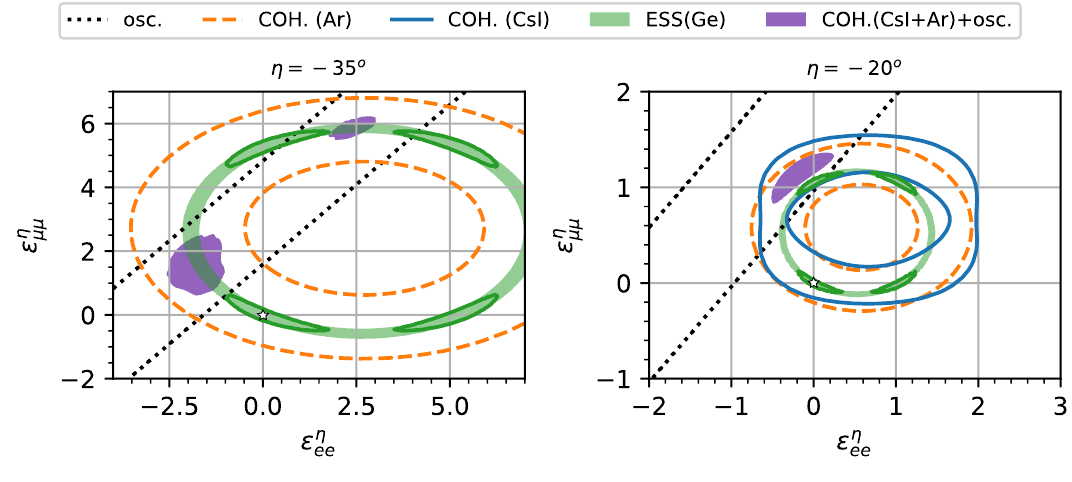
Figure 6 . Same as figure 2 but showing allowed regions at 3 σ from a Ge target at a stopped pion source assuming a precision of σ/Q 2 = 0 . 028 , a factor 5 better than the ESS assumption from [23]. SM For the green-shaded region (green-solid contours) we assume σ µ /σ = ∞ (4 . 2) .